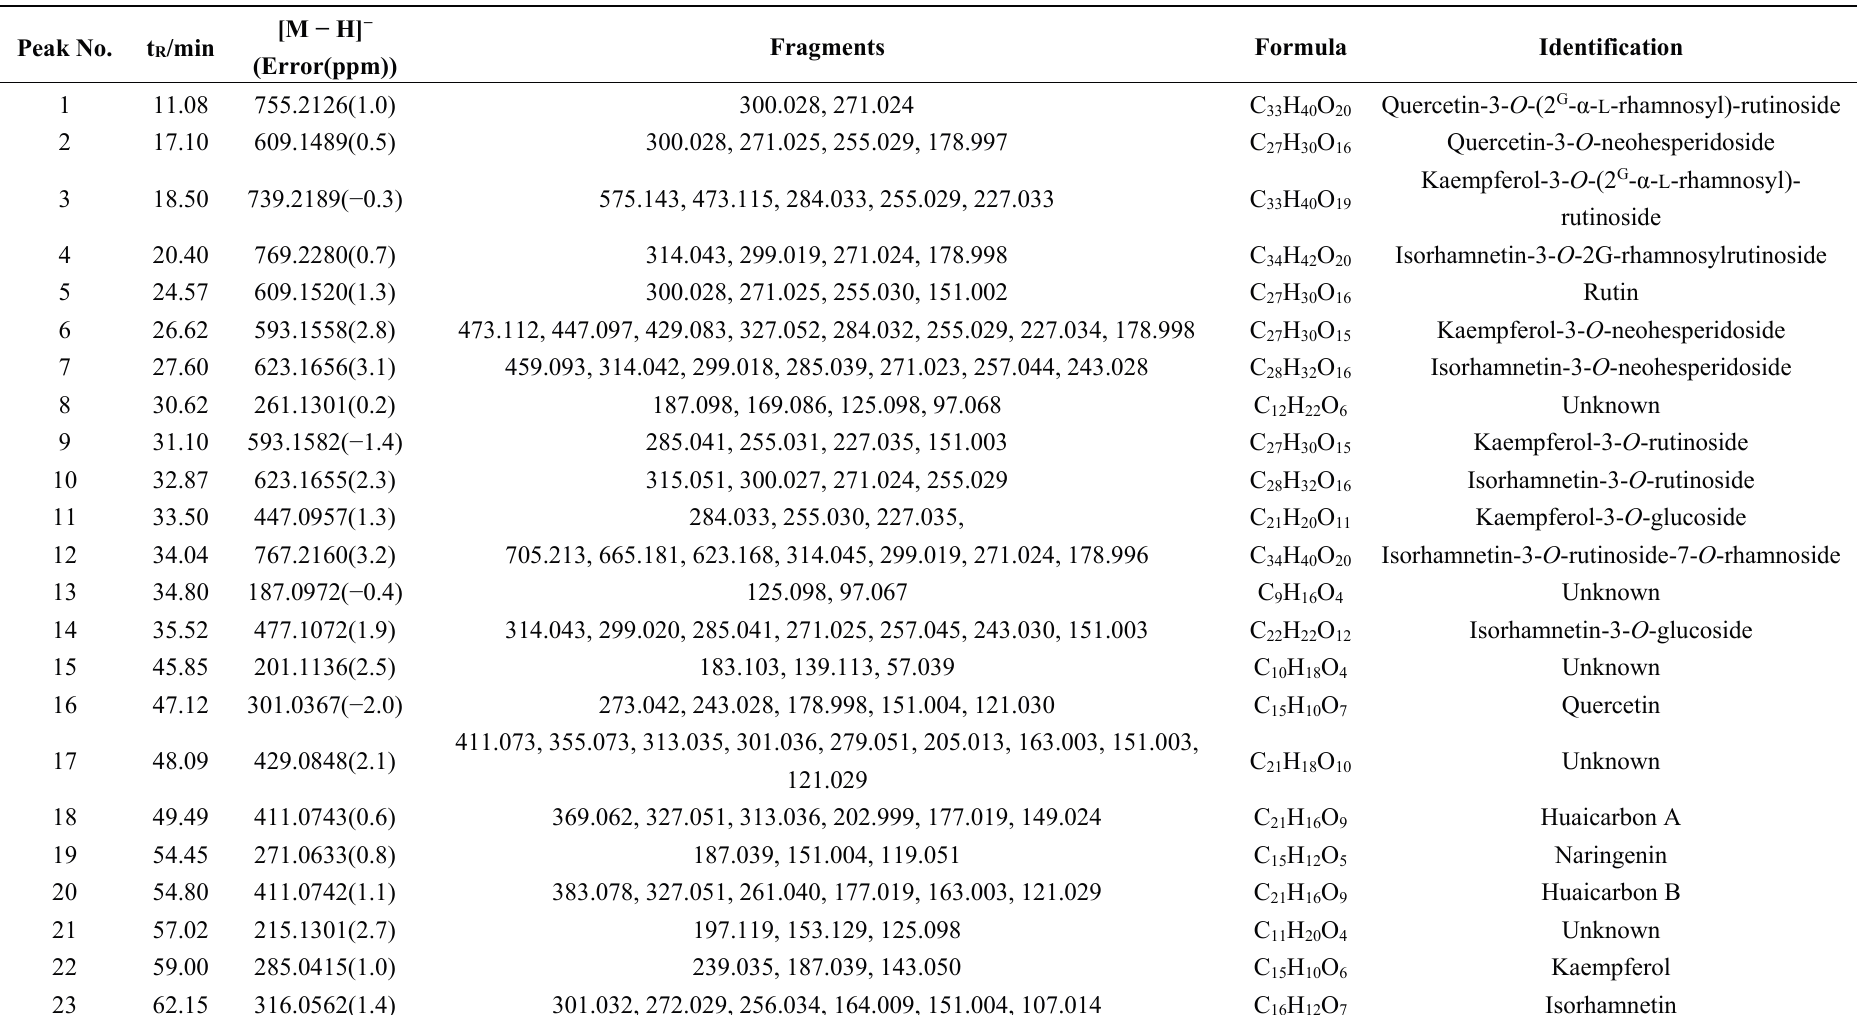
Table 1. Characteristics of 23 peaks from FPT-N by HPLC-MS/MS in negative